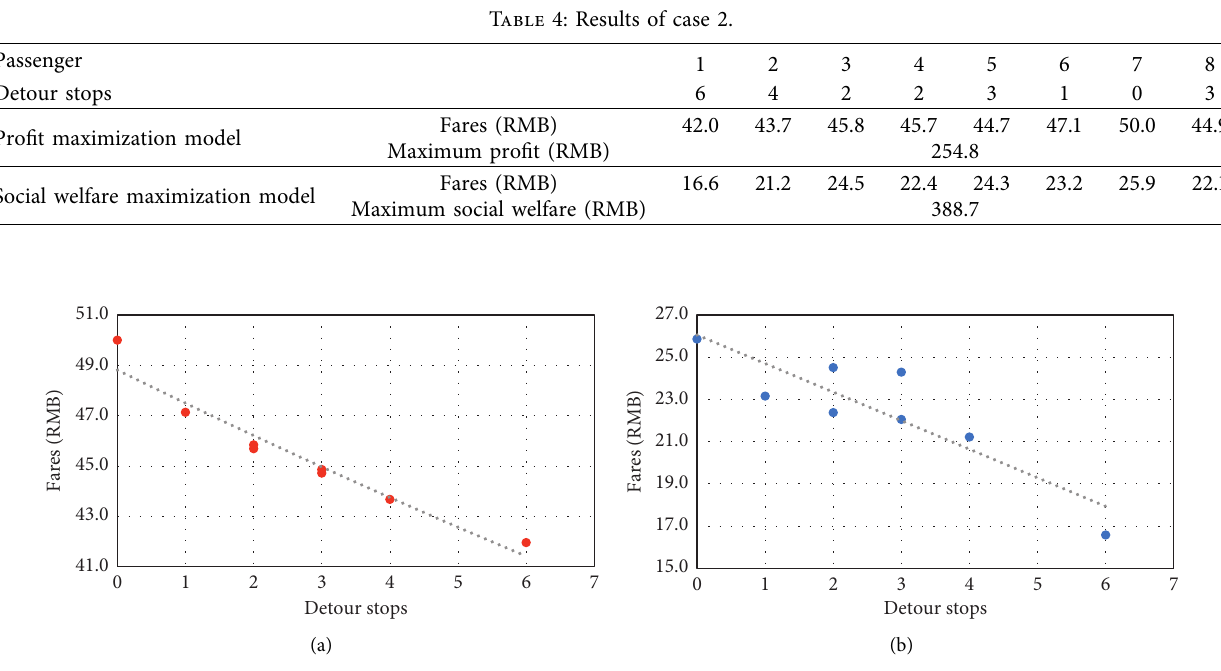
Figure 8: The relationship between detour stops and fares in Case 2. (a) The profit maximization model, (b) The social welfare maximization